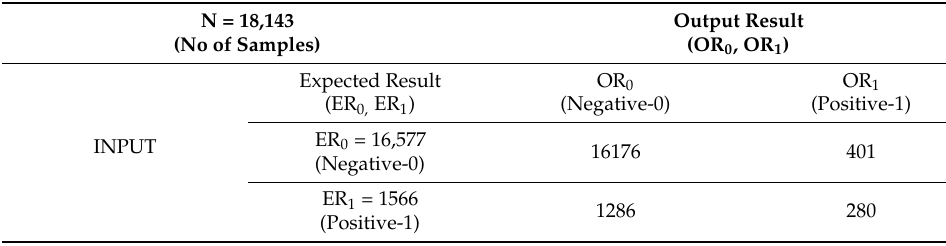
Table 6. Naïve Bayes training results.